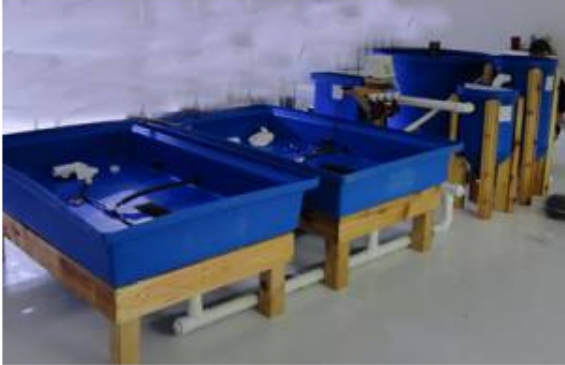
Figure 6. Nelson Pade’s aquaponics system for use at home or school (Nelson Pade’s Inc.,